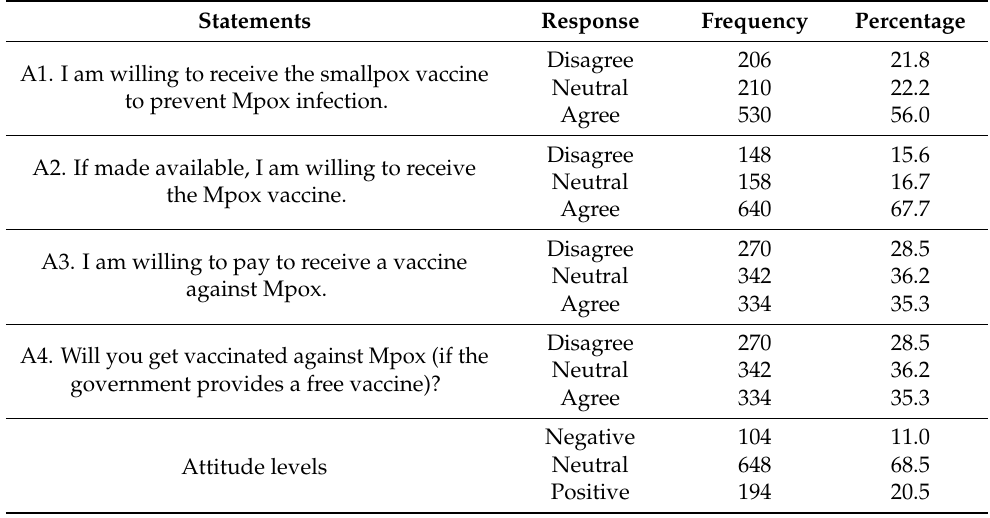
Table 3. Attitudes of respondents toward vaccination toward